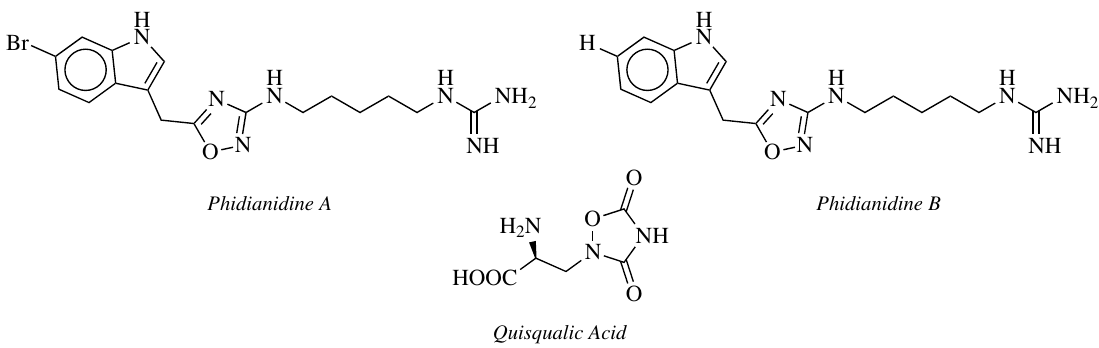
Figure 4. Chemical structures of naturally occurring 1,2,4-oxadiazole-containing